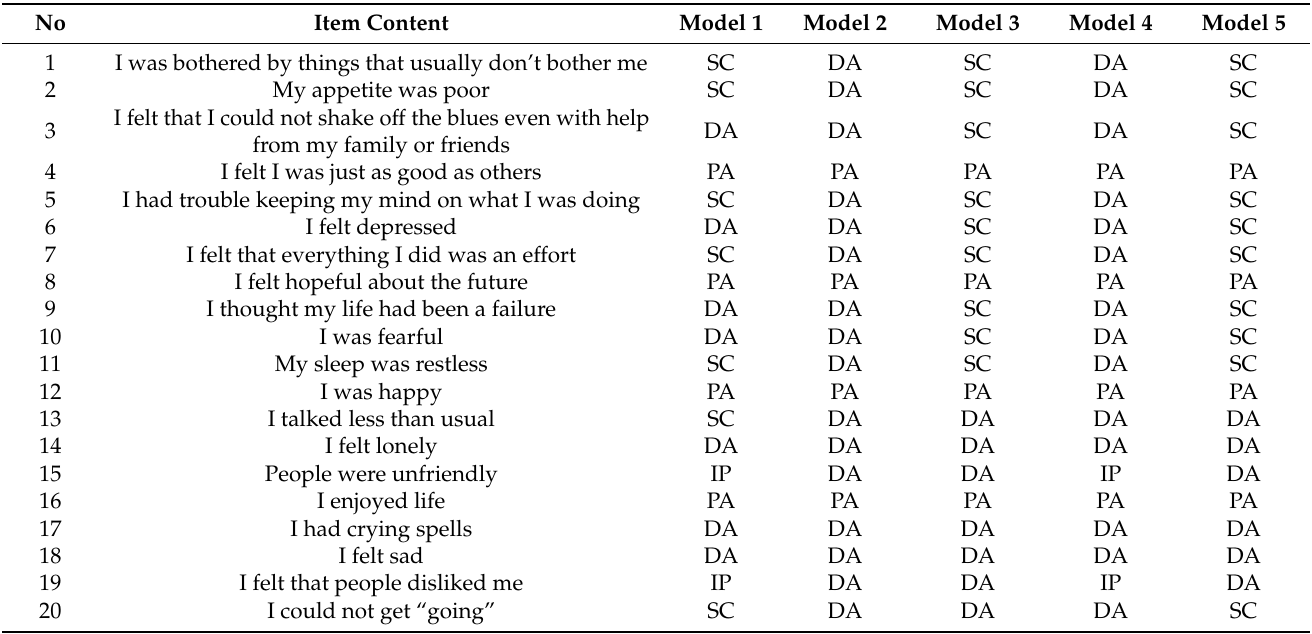
Table 1. Item mapping for tested competing